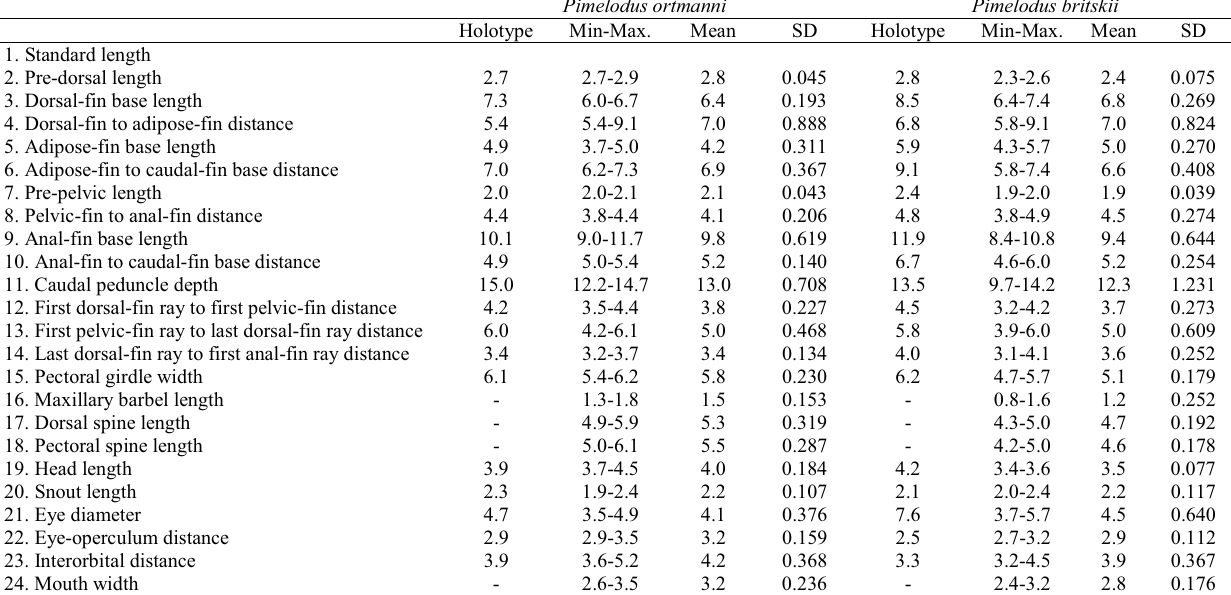
Table 1. Morphometrics of Pimelodus britskii (n=25) and Pimelodus ortmanni (n=18) from rio Iguaçu basin. Items 1-19 as ratio of the standard length, 20-24 as ratio of the head length. Min. = minimum, Max. = maximum, SD = Standard deviation. Pimelodus ortmanni Pimelodus britskii Holotype